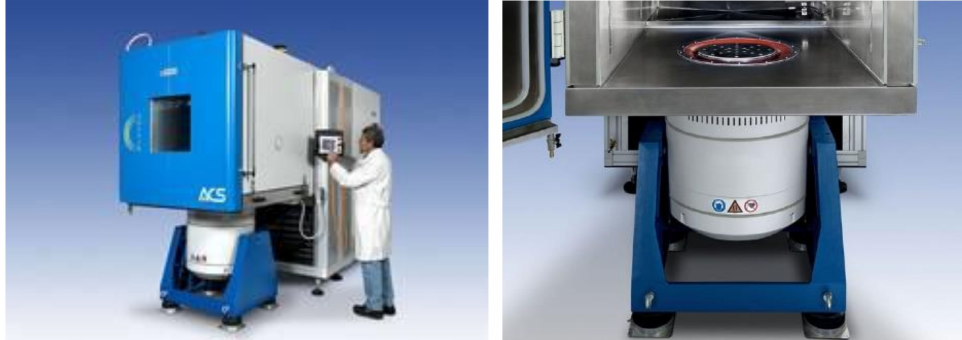
Figure 2. Angelantoni CH250 climatic chamber + TIRA S55240/LS—Vibration